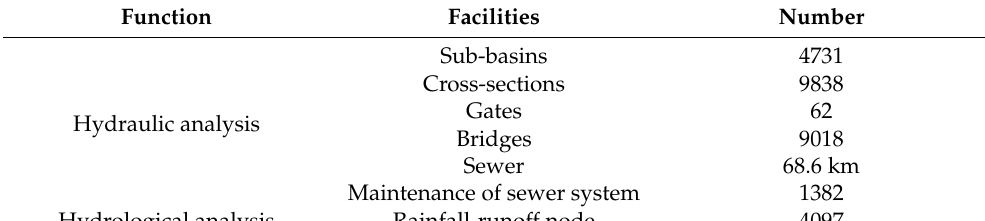
Table 3. Summary of computation objects adopted in the SOBEK model regarding Miaoli County.